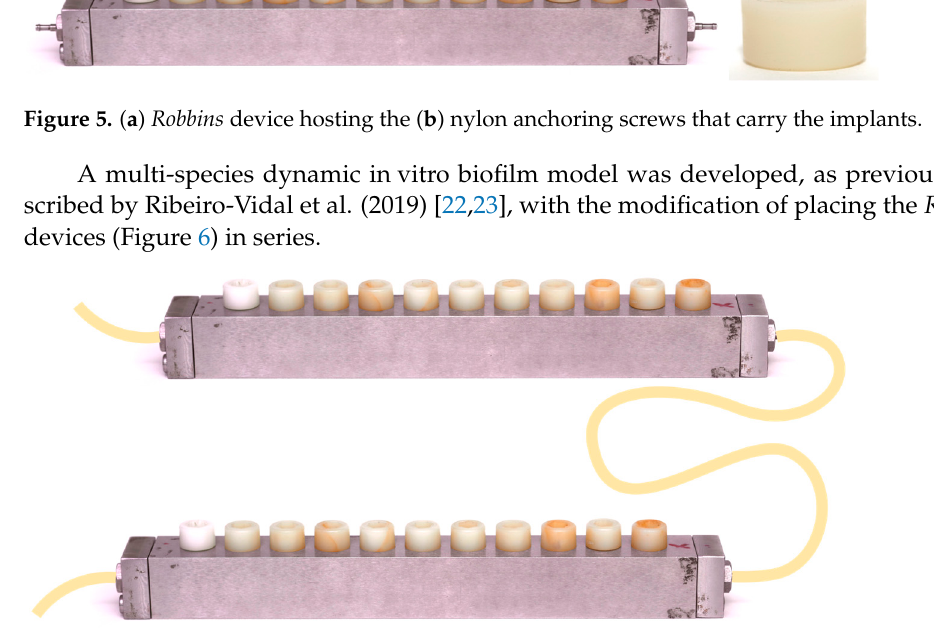
Figure 6. Schematic representation of Robbins devices placed in series hosting the implants.